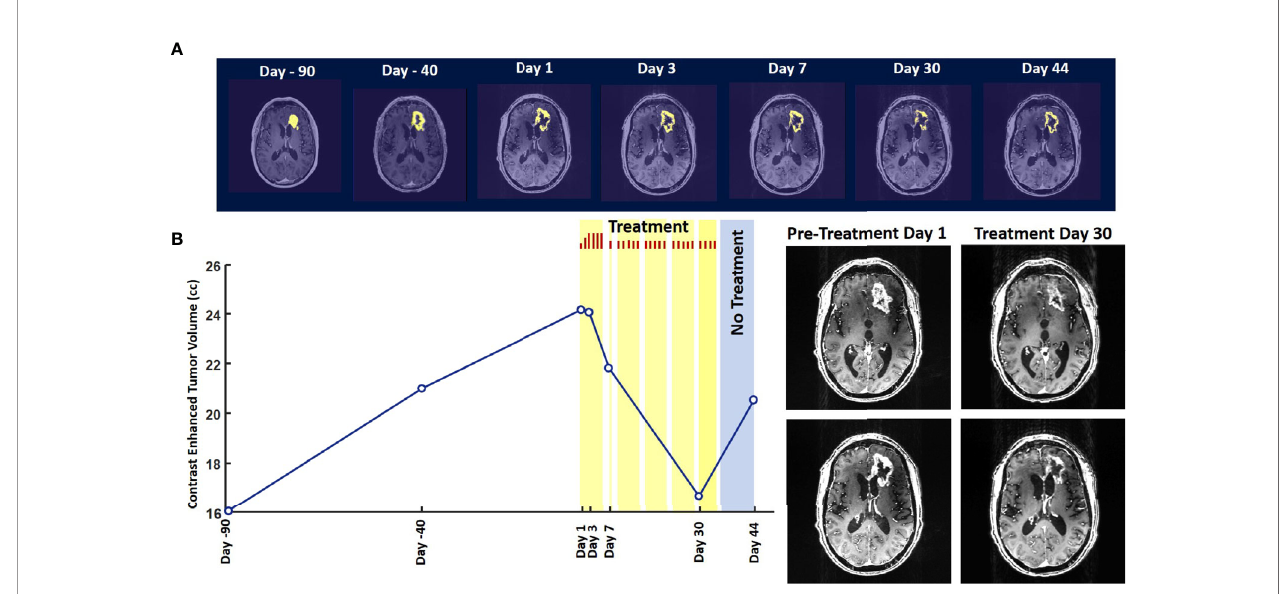
FIGURE 2 | Change in Contrast-Enhanced Tumor Volume. (A) T1-weighted axial post-contrast scans showing the contrast-enhanced tumor (CET) highlighted with an overlayed automated computer program-generated light-yellow mask at different time points (B) Left – A graph showing the change in CET volume over time. The treatment times and durations are shown as red bars and light-yellow highlights. The long pause in treatment is shown as a light-blue highlight. Right – T1-weighted axial post-contrast scans showing CET at two levels along the dorso-ventral axis at Day 1 before treatment and Day 30 of